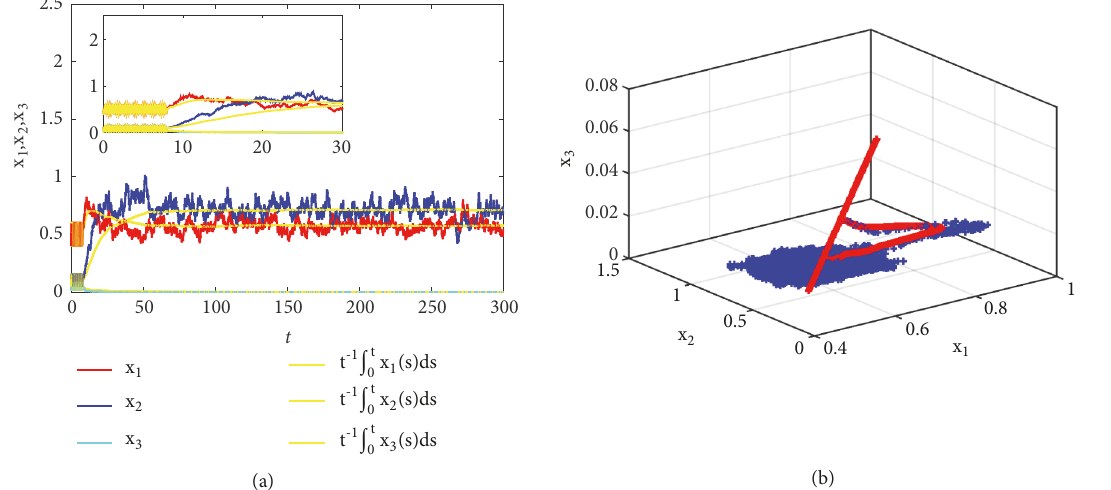
Figure 3: The persistence in mean of two preys is given in Theorem 11. (b) stands for the phase portrait of (a). The density of white noises is taken: 𝜎 1 = 0.5, 𝜎 2 = 0.9, 𝜎 3 = 12